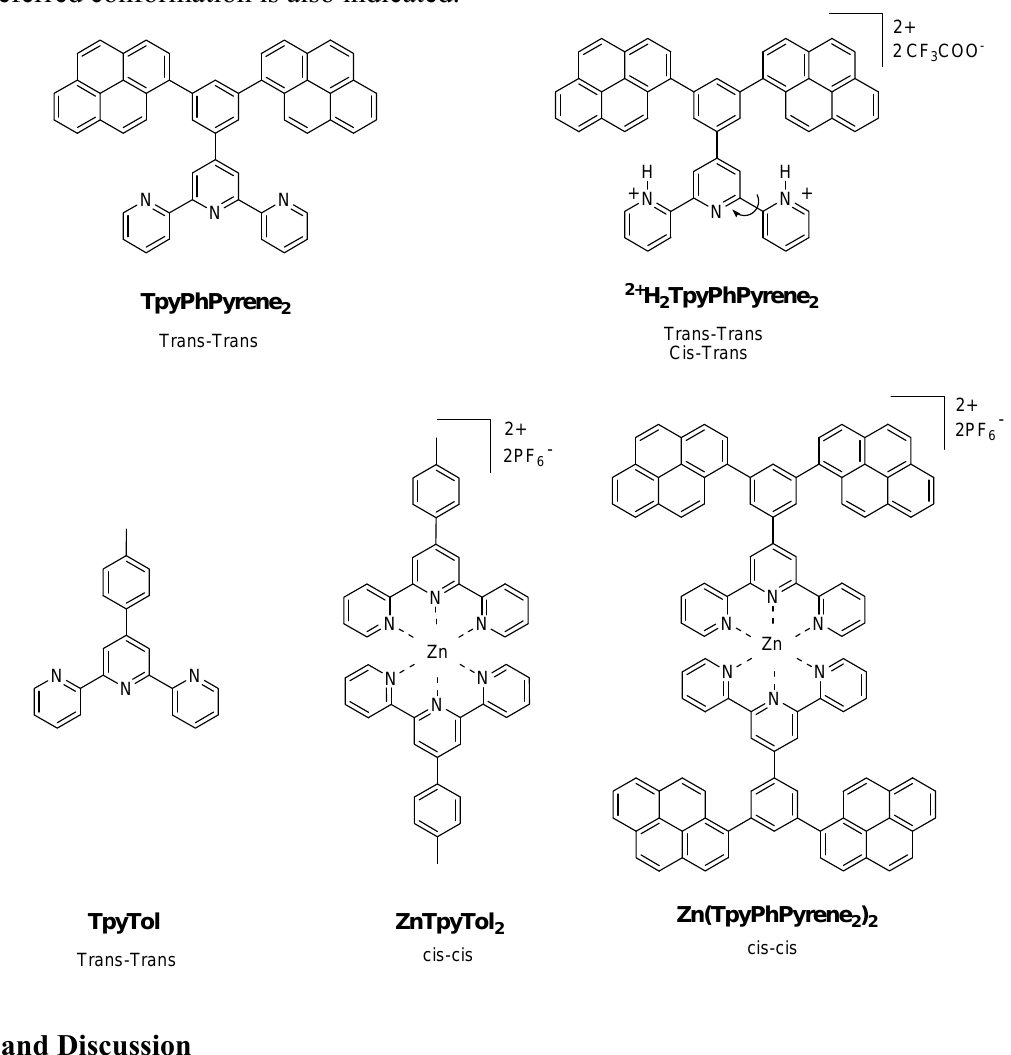
Figure 1. Structures and abbreviations of the molecules synthesized and investigated. Preferred conformation is also